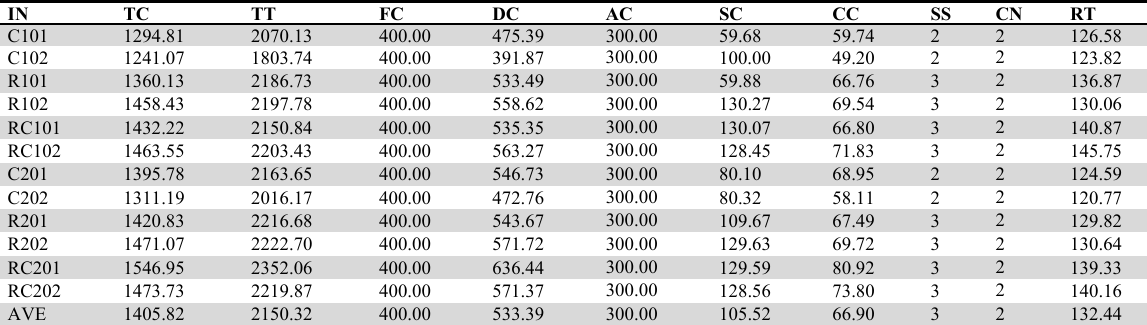
The experimental results of HOTDMDEVRPBRS for different